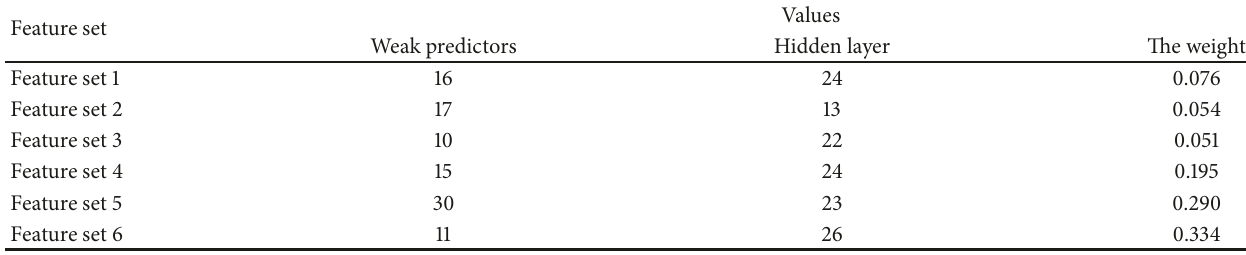
Table 6: Main parameters of the weighted Adaboost-ENN model.